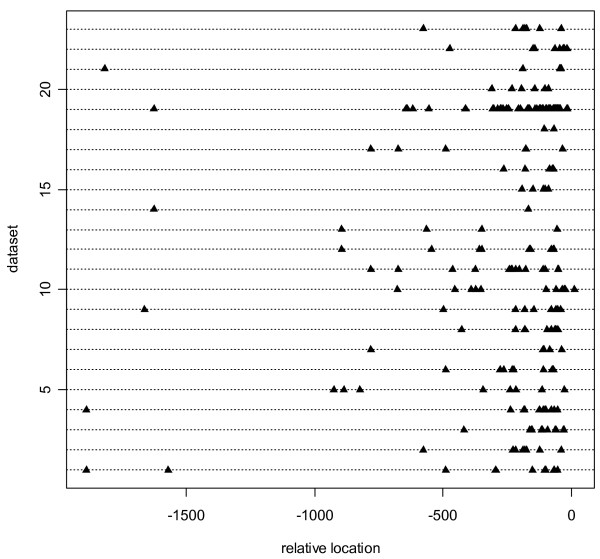
Distribution of known locations of binding site in TSS Tompa dataset. The x-axis is anchored on the TSS, denoted as location 0. All sequences in each test subset are collapsed into a single line; hence the 23 data subsets are shown as 23 different horizontal lines. Each data subset contains TFBSs corresponding to a single specific transcription factor.